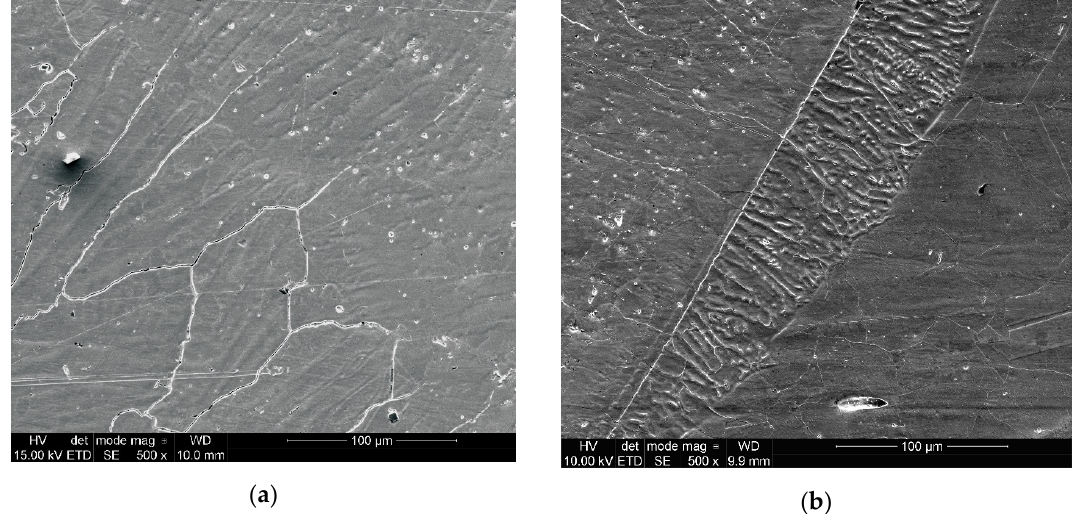
Figure 12. SEM micrograph showing interface between ( a ) weld–fusion line and Incoloy 800HT nickel alloy and ( b ) weld–fusion line and 304L austenitic stainless steel.